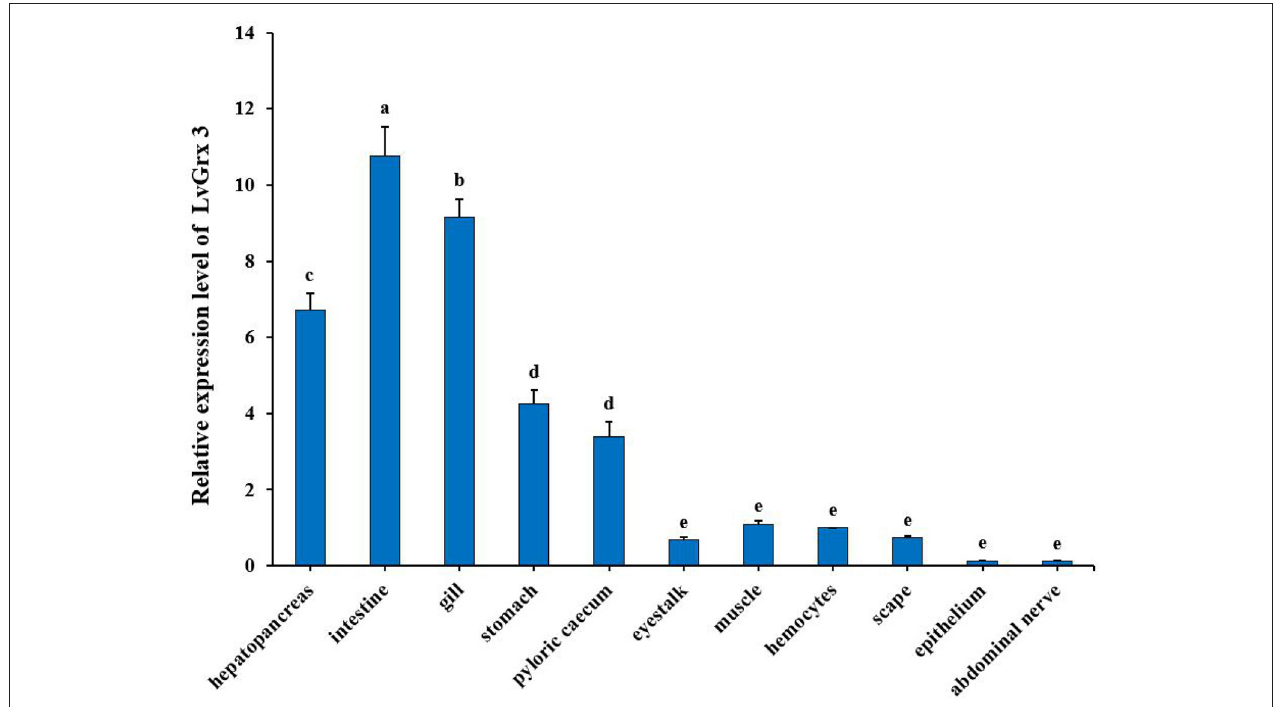
FIGURE 4 | Relative expression of Grx 3 in different tissues of Pacific white shrimp ( Litopenaeus vannamei ), such as hepatopancreas, intestine, gill, stomach, pyloric cecum, eyestalk, muscle, hemocytes, scape, epithelium, and abdominal nerve ( P < 0.05). The calculated data in the same group with different letters are significantly different ( P < 0.05).